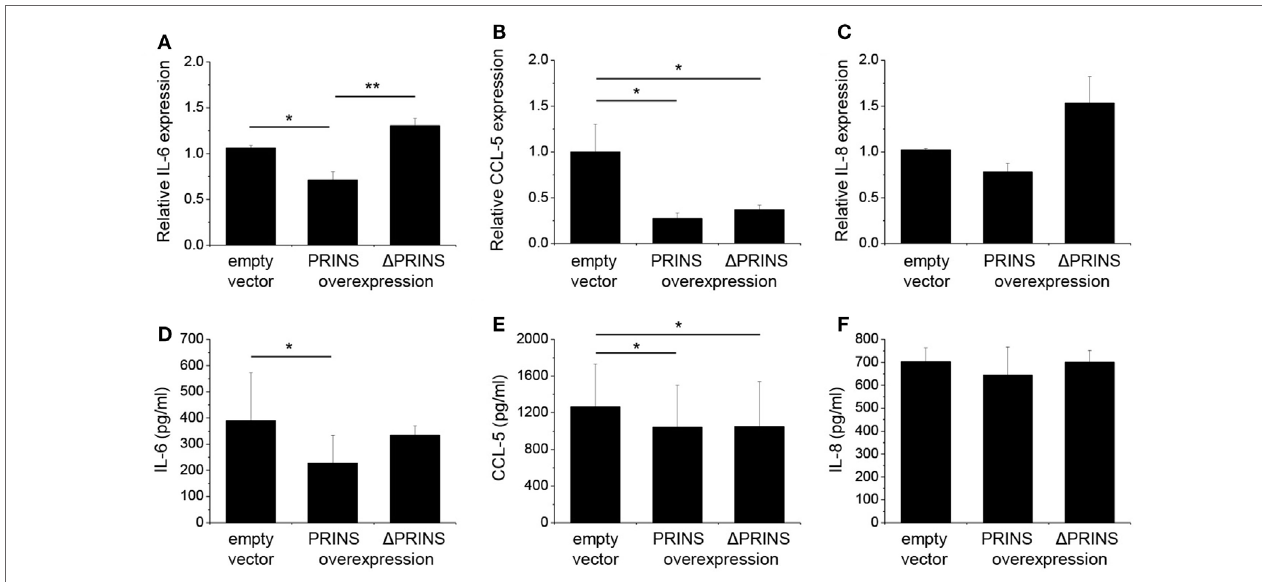
FigUre 6 | The 538–622 nt region of PRINS is required for the regulation of interleukin-6 (IL-6) expression. In parallel to priming with 5 ng/ml tumor necrosis factor- α and interferon- γ , normal human epidermal keratinocytes were transfected with a pcDNA3.1( + ) vector containing the PRINS cDNA or the Δ PRINS cDNA (containing a scrambled version of the IL-6 binding site at positions 538–622 nt); the empty pcDNA3.1( + ) vector served as control, after 24 hours cells were transfected by poly(dA:dT). Expression of cytokines IL-6 (a) , CCL-5 (B) , and IL-8 (c) was detected by real-time RT-PCR. Secretion of cytokines IL-6 (D) , CCL-5 (e) , and IL-8 (F) was detected by ELISA from cell supernatants. Nucleotide positions based on the AK022045 reference sequence. Data are presented as mean ± SE of three independent experiments (* p ≤ 0.05; ** p ≤